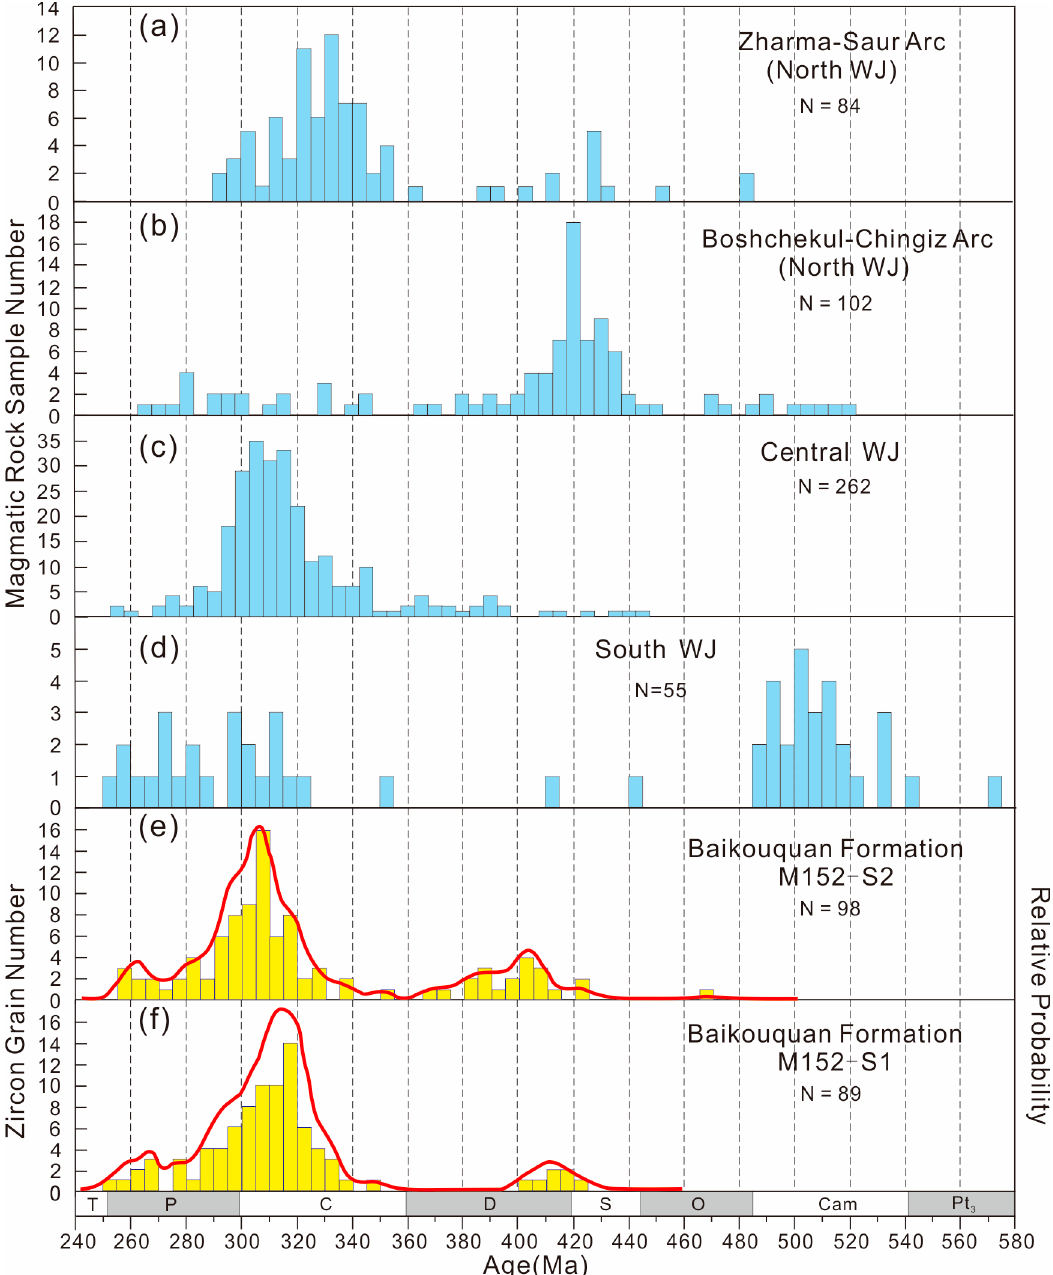
Figure 8. Magmatic rocks age distribution from ( a ) Zharma–Saur arc of North WJ, ( b ) Boshchekul– Chingiz arc of North WJ, ( c ) Central WJ, and ( d ) South WJ areas. ( e , f ) Frequency and relative probability density curves for detrital zircons U-Pb ages from the Xiazijie fan-delta.